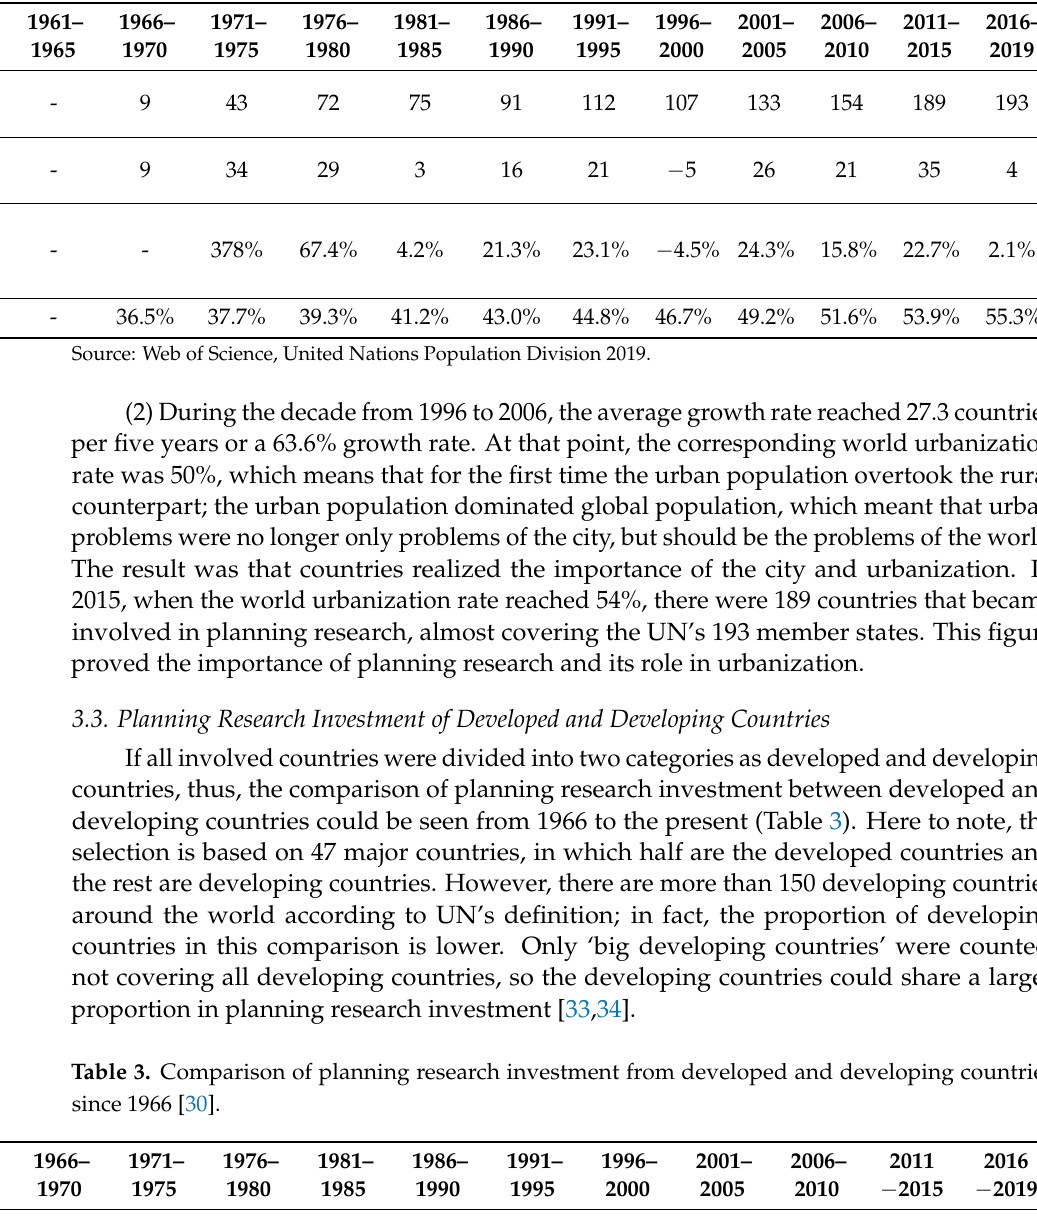
Table 2. The number of participating countries in planning research has changed since 1961 [30,32].